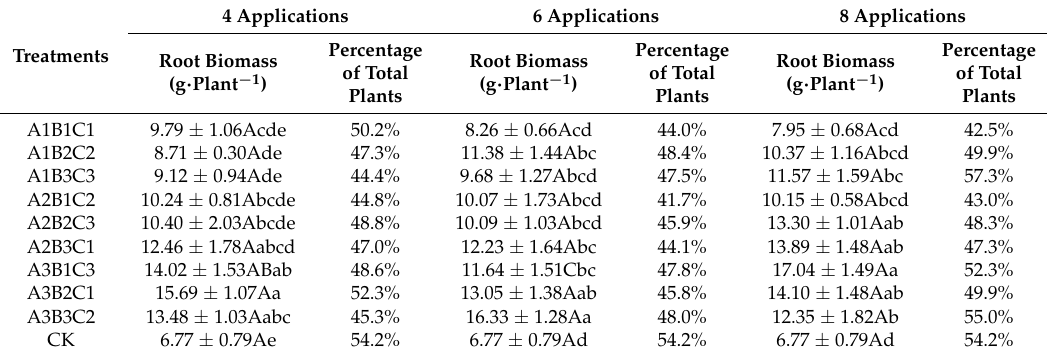
Table 7. Effects of different fertilization ratios and frequencies on root biomass.